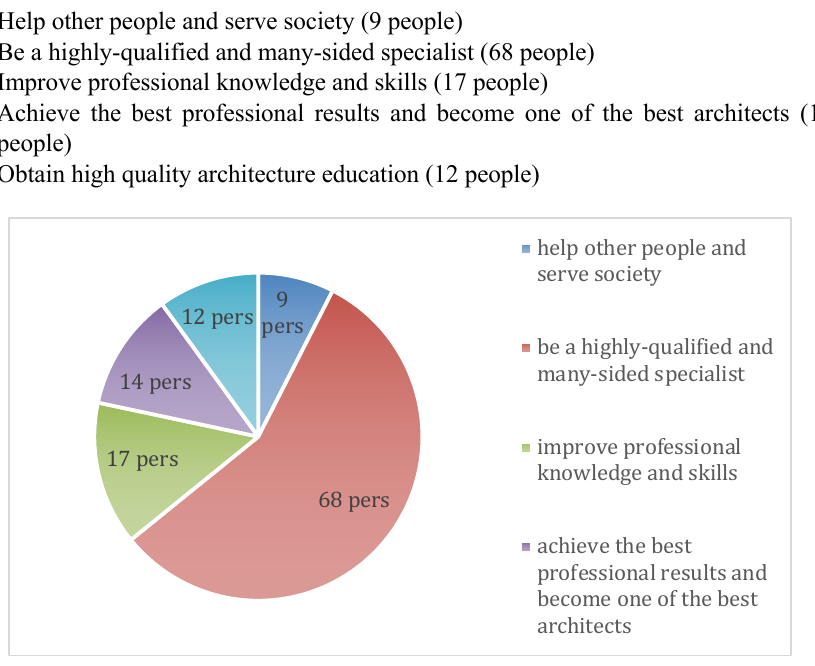
Fig. 1. Motivational incentives of architecture students to conduct professional